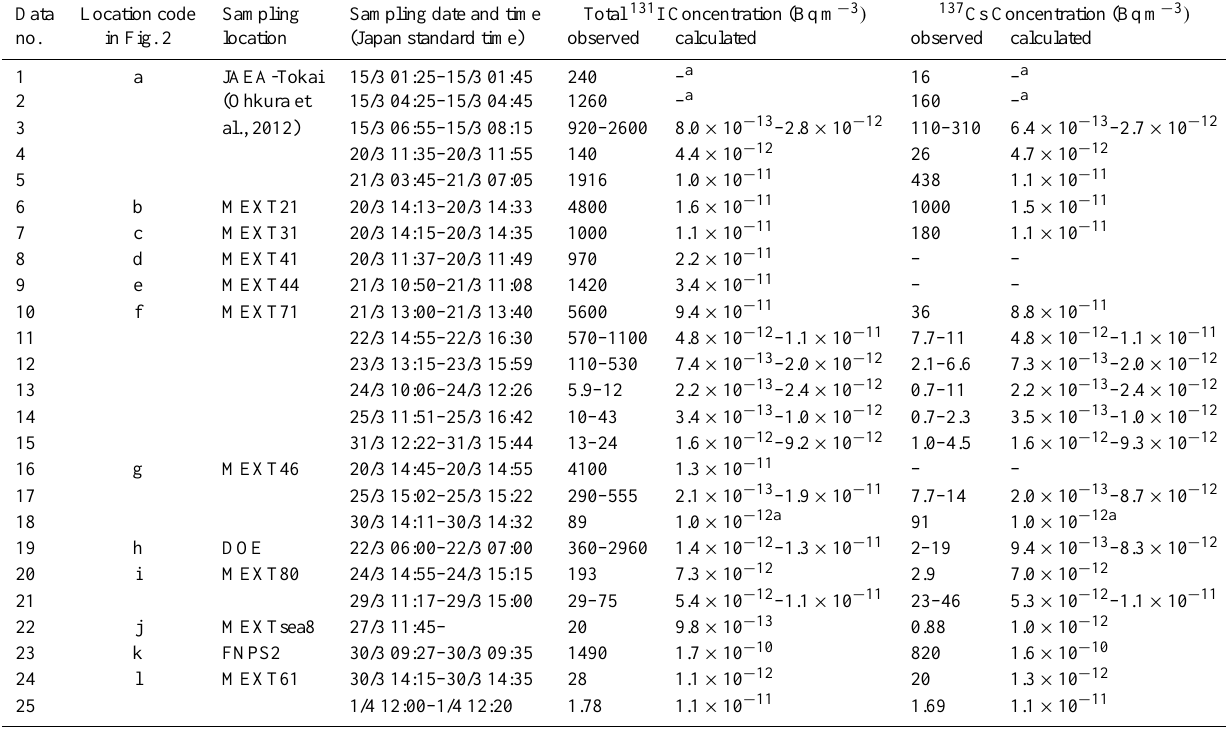
Table 2. Dust sampling data used for the source term estimation. The locations of monitoring data are illustrated in Fig. 2. The concentration calculations for source term estimation were carried out under the assumption of unit release rate (1Bqh − 1 ) .